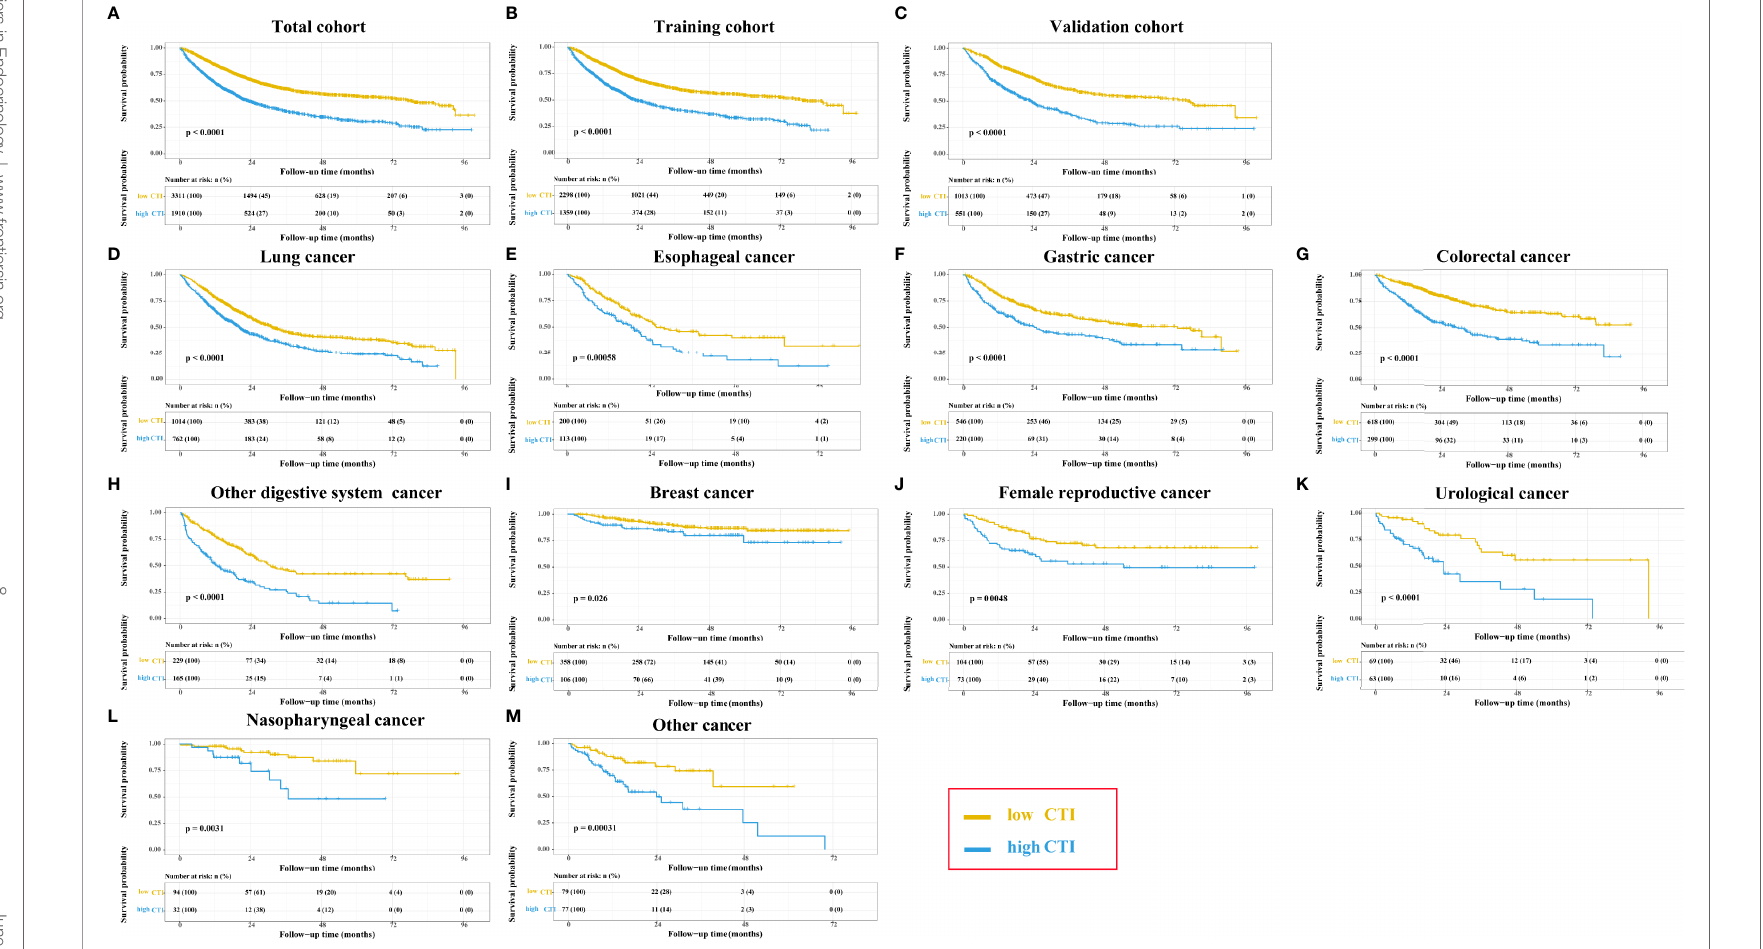
FIGURE 4 | The Kaplan-Meier survival curves of CTI in the different cohorts of patients with cancer. (A) Total cohort; (B) Training cohort; (C) Validation cohort; (D – M) Different tumor types based on total cohort: (D) Lung cancer; (E) Esophageal cancer; (F) Gastric cancer; (G) Colorectal cancer; (H) Other digsestive cancer; (I) Breast cancer; (J) Female reproductive cancer; (K) Urological cancer; (L) Nasopharyngeal cancer; (M) Other cancer; CTI, C-reactive protein-triglyceride glucose